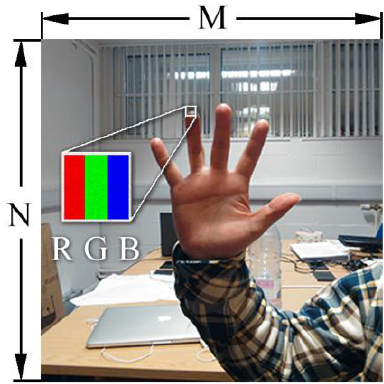
Figure 2. The RGB format hand gesture image.